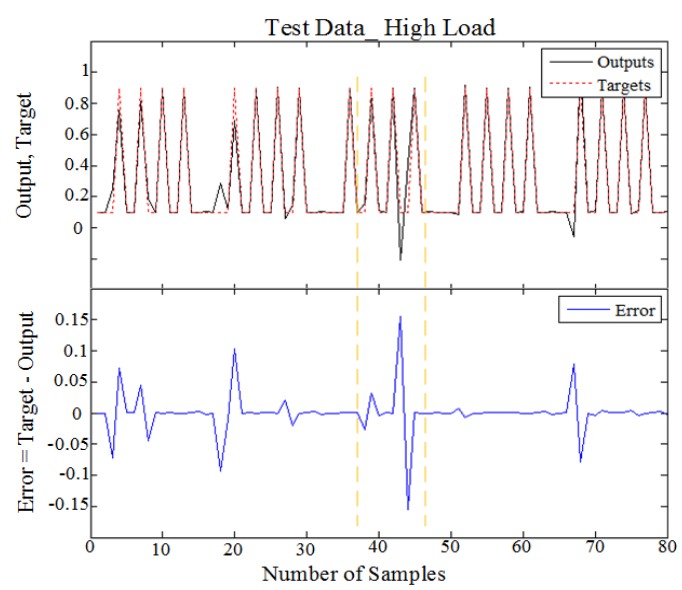
Figure 13. The Error between Real Output and Desired for Testing Data Set in 80% of Full Load.